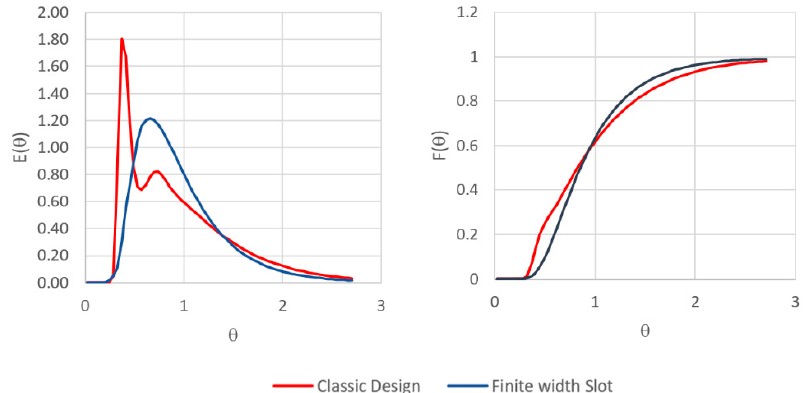
Figure 10. E( θ ) and F( θ ) plots obtained from tracer simulations for contact tank with finite width slots and classic design cases.